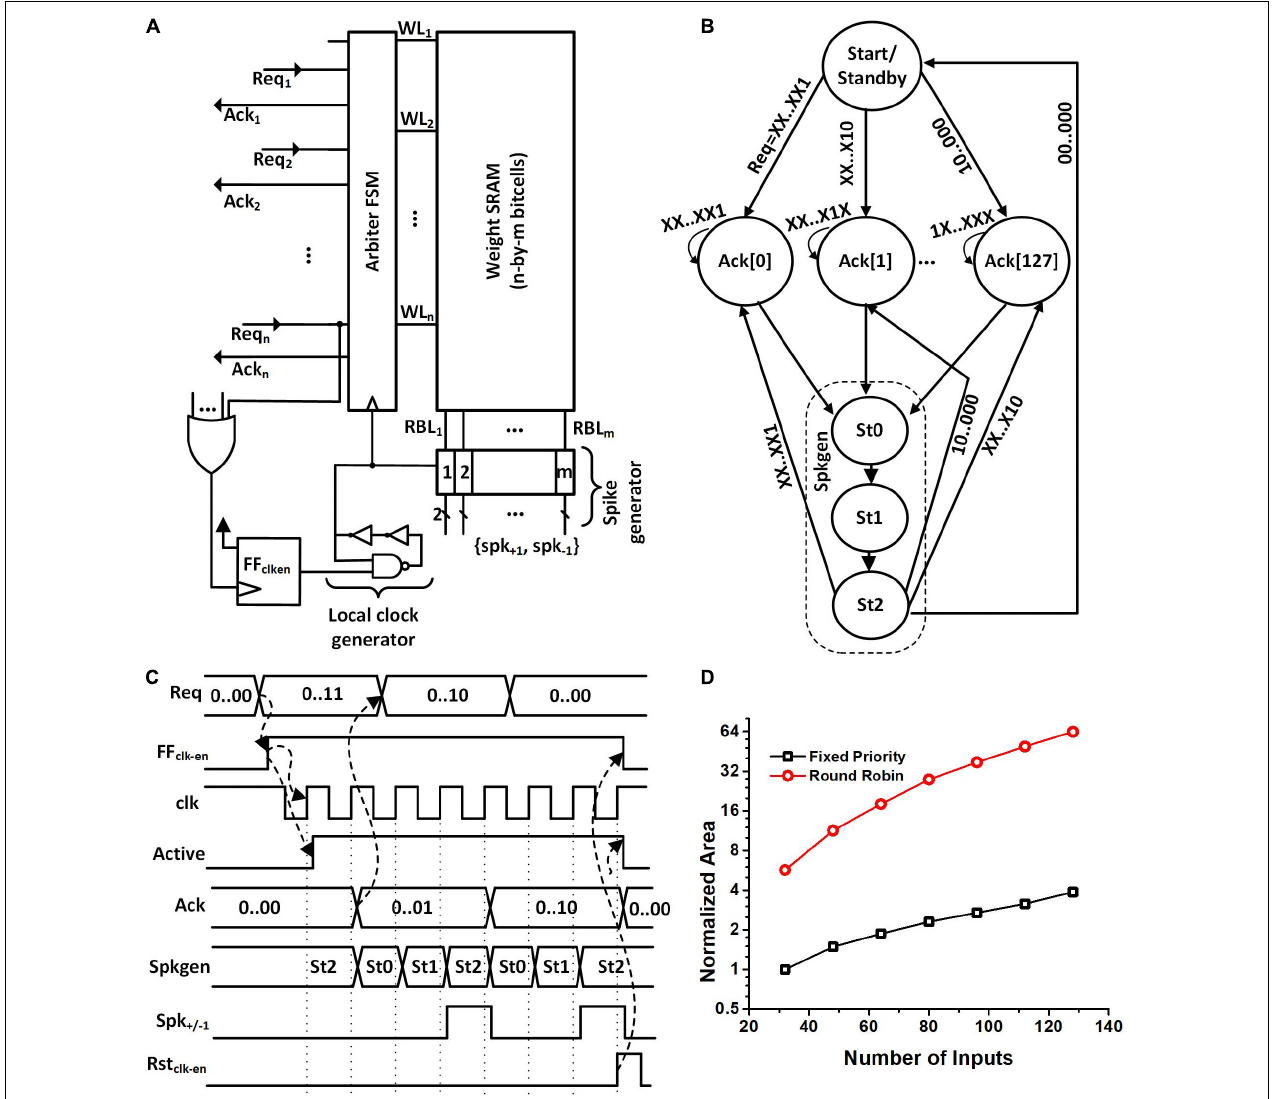
FIGURE 5 | (A) Proposed synapse block architecture. (B) Arbiter FSM showing the fixed priority and Spkgen sub-FSM. (C) Waveforms showing the operation of the synapse block when neuron 1 and 2 generate a request. Acknowledgment is given to neuron 1 because of higher priority. Spkgen sub-FSM executes while the acknowledgment is high. (D) Normalized area comparison between round-robin arbiter and fixed priority arbiter for a different number of inputs. The normalized area is obtained by dividing the cell area with the area of the fixed priority arbiter with 32 inputs.